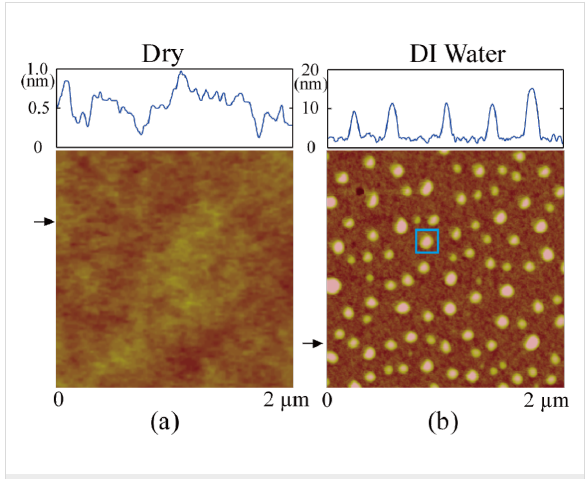
Figure 3: Comparison of AFM images of a PS surface in air (a) and in DI water (b).